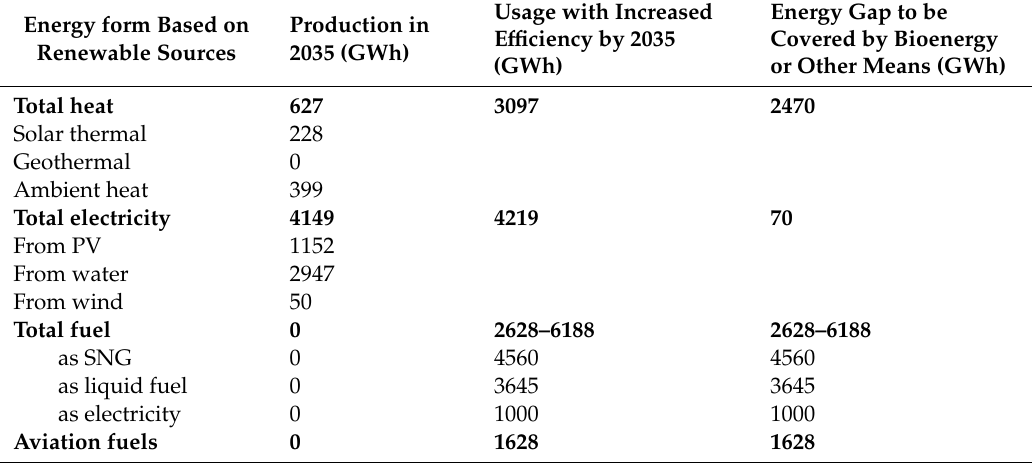
Table 2. What contribution should bioenergy make in 2035? An estimate derived from the di ff erence between renewable energy production and the demand for heat, electricity, and